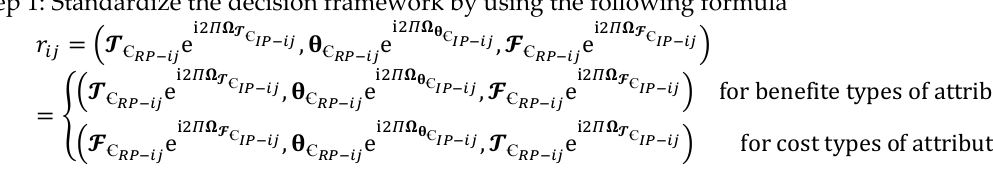
Table 1. Decision matrix .